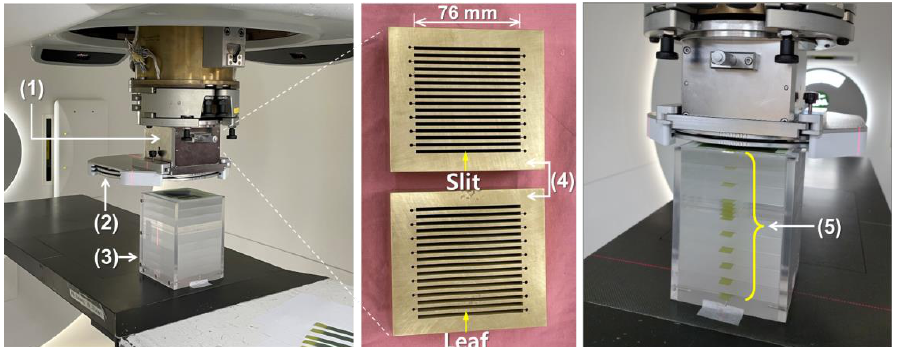
Figure 1. Experimental setup for dosimetry of proton minibeams: (1) an multislit collimator (MSC) housing, (2) a scattering device, (3) a polymethylmethacrylate (PMMA) phantom, (4) first and second 5 cm thick MSCs, (5) EBT3 film strips inserted at every 2 cm depth (except for one depth section) in the PMMA phantom that are perpendicular to the proton beam direction.